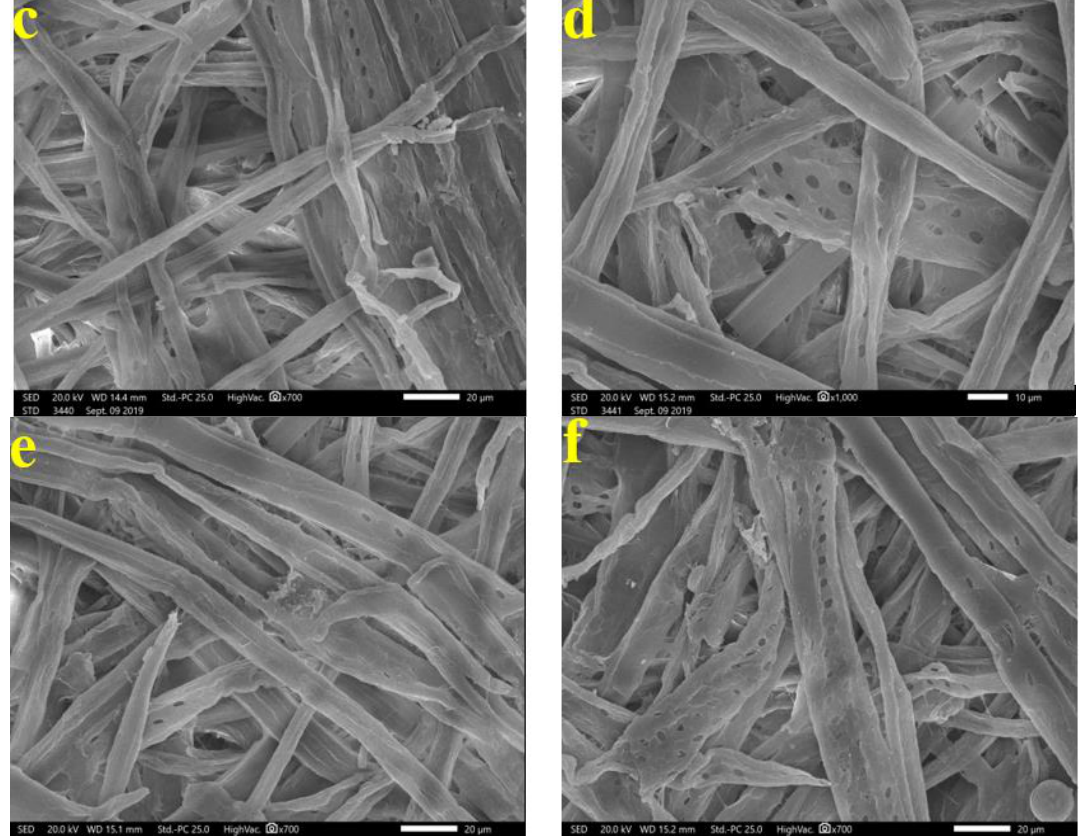
Figure 11. SEM images show inhibition of fungal growth on E. camaldulensis WB pulp paper manufactured with the addition of HeOEs and inoculated with A. terreus : ( a ) with M. azedarach HeOE at 3%; ( b ) with M. azedarach HeOE at 5%; ( c ) with S. alba HeOE at 3%; ( d ) with S. alba HeOE at 5%; ( e ) with M. grandiflora HeOE at 3%; ( f ) with M. grandiflora HeOE at 5%.